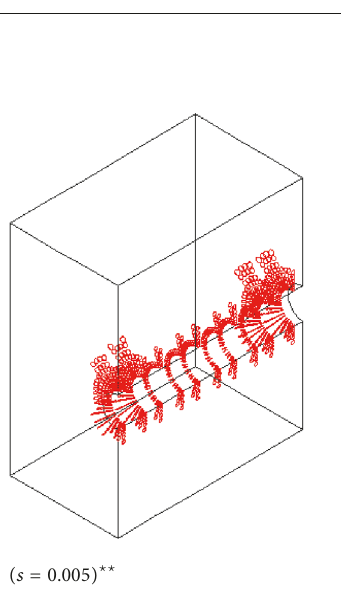
Figure 9: Beam segment model for simulating the displacement caused by corrosion-induced rebar expansion under stress. Figure 10: Displacement resulting from corrosion-induced expan- sion = 0.005 mm.